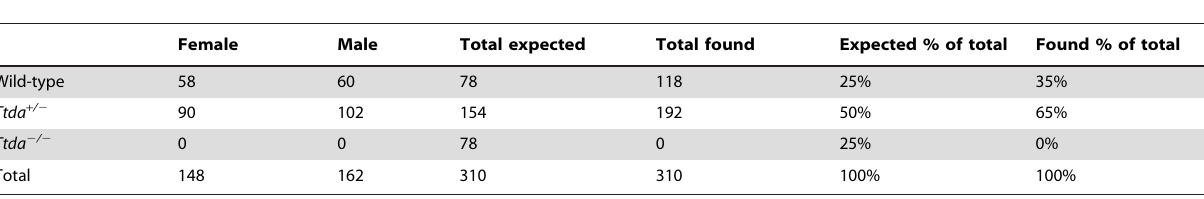
Table 1. Genotyping and offspring from Ttda + / 2 mice